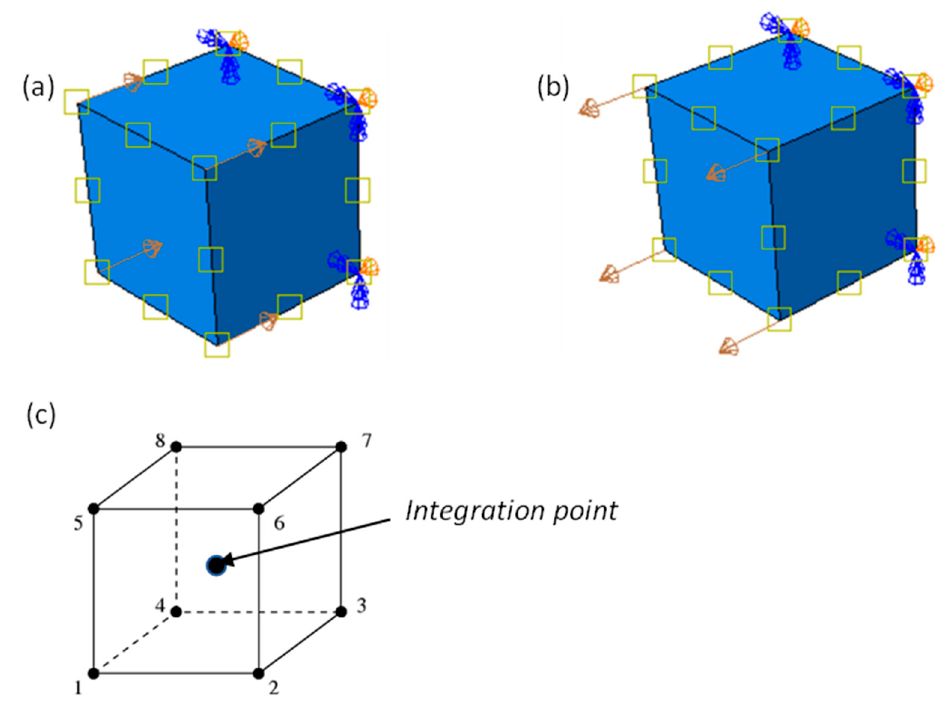
Figure 3. ( a , b ) A single element model with boundary conditions and ( c ) the 8-node linear brick